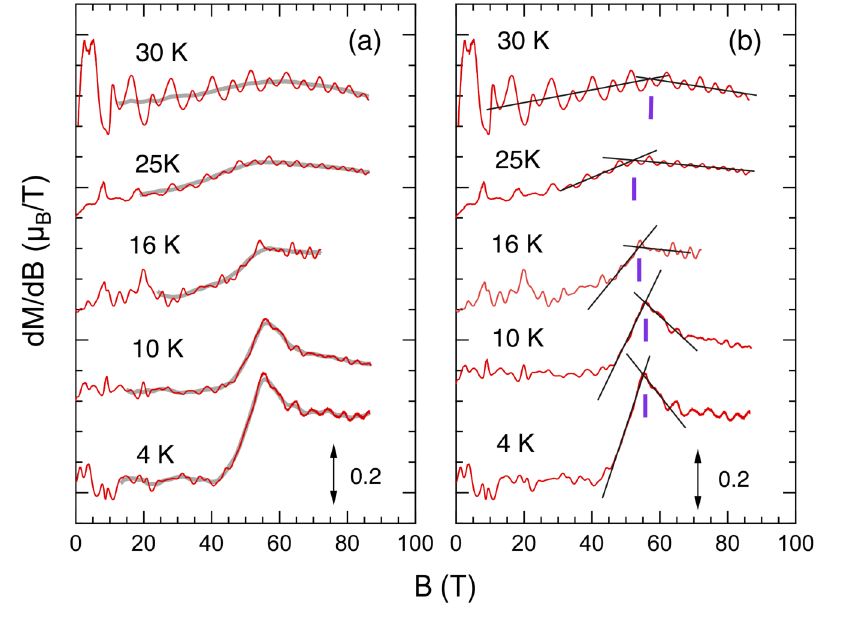
Figure 2. ( a ) Derivative of the magnetization with respect to the magnetic fields ( dM / dB ) at different temperatures. The thin light-gray curves are the dM / dB after a numerical smoothing process. ( b ) The method of determination of the transition magnetic fields. The lines are tangential lines in the vicinity of the peaks.